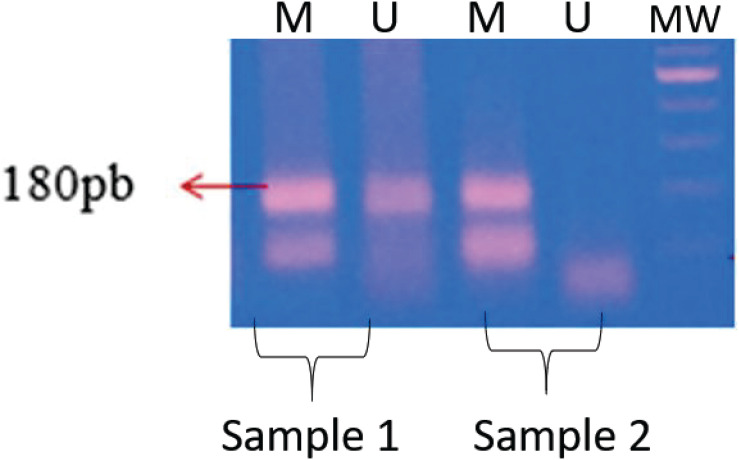
Methylation profile of the MTHFR gene. Methylation patterns of MTHFR gene samples. Sample 1, partially methylated pattern; sample 2, fully methylated pattern; MW, 100 bp pattern. M = methylated/U = unmethylated.